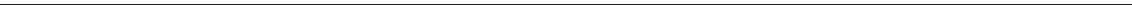
FIGURE 9 | Emx1 Cre ;Tag-1 DTA mice reveals that the corpus callosum and anterior commissure (both structures depicted by white arrowheads) are greatly reduced upon ablation of TAG-1 + neocortical neurons. (E) Micro-computed tomography ( µ CT) of the adult brain (4 months old) and 3D reconstruction reveal a decrease in the thickness and overall reduction in the volume of the corpus callosum and a severely malformed anterior commissure in Emx1 Cre ;Tag-1 DTA mice. (F) Following anterograde DiI tracing on P0 dissected brain by DiI placement on the anterior olfactory nucleus (Luukko et al., 2008), it was visualized that the neurons of the AON are not projecting normally toward the midline in Emx1 Cre ;Tag-1 DTA mice, as compared to controls ( Tag-1 EGFP ). Cc, corpus callosum, ac, anterior commissure, ig, indusium griseum, AON, anterior olfactory nucleus.